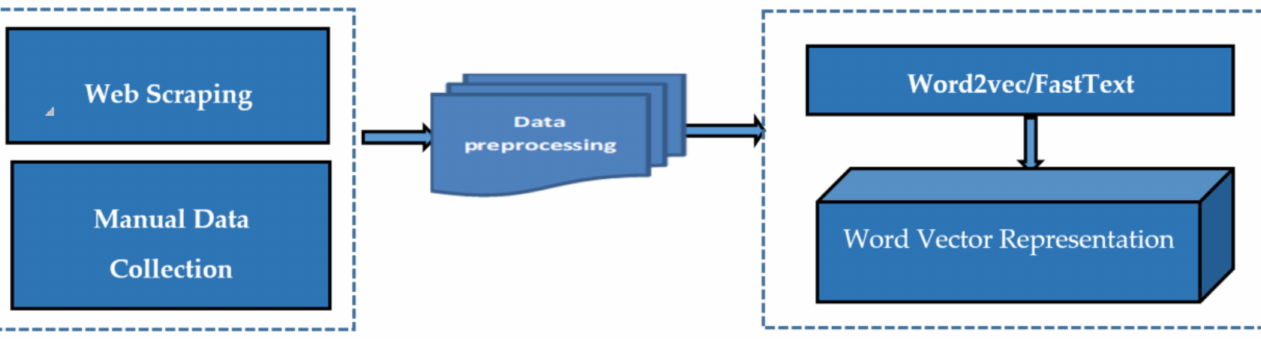
Figure 4. Summary for Tigrinya word embedding. The left section of the figure describes the data collection process. The middle section shows the data-preprocessing step. The right section describes the word embedding